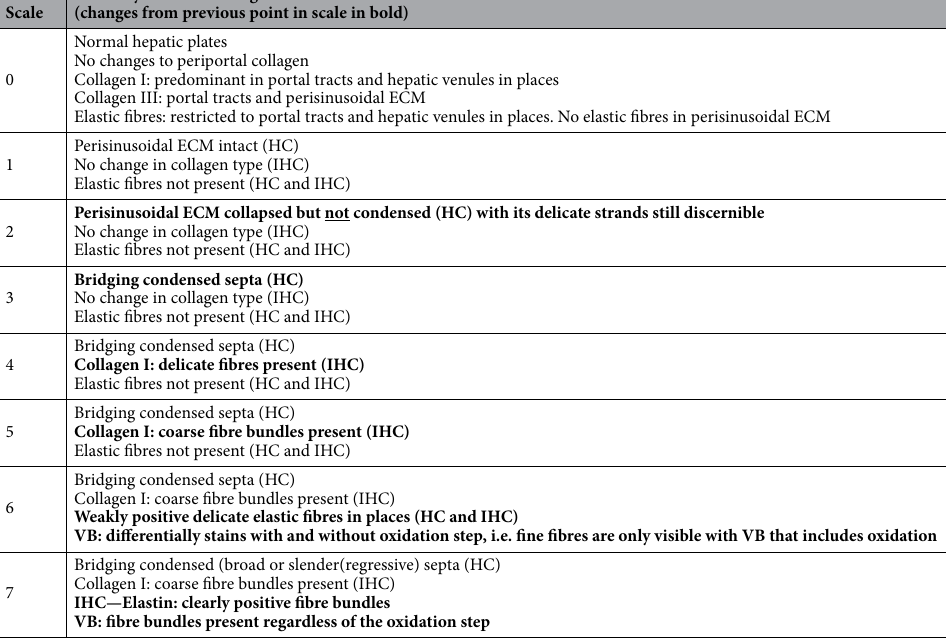
Table 3. Parenchymal ECM changes. Please note that the difference between 0 and 1 on the scale is the presence of hepatocyte injury usually in the form of zonal or sometimes panlobular/multilobular hepatocyte loss. H&E: Haematoxylin and eosin. HC: Histochemical stains (e.g. reticulin, orcein, Victoria blue (VB), picrosirius red (SR). IHC: immunohistochemical stains (e.g. collagen I, collagen III,